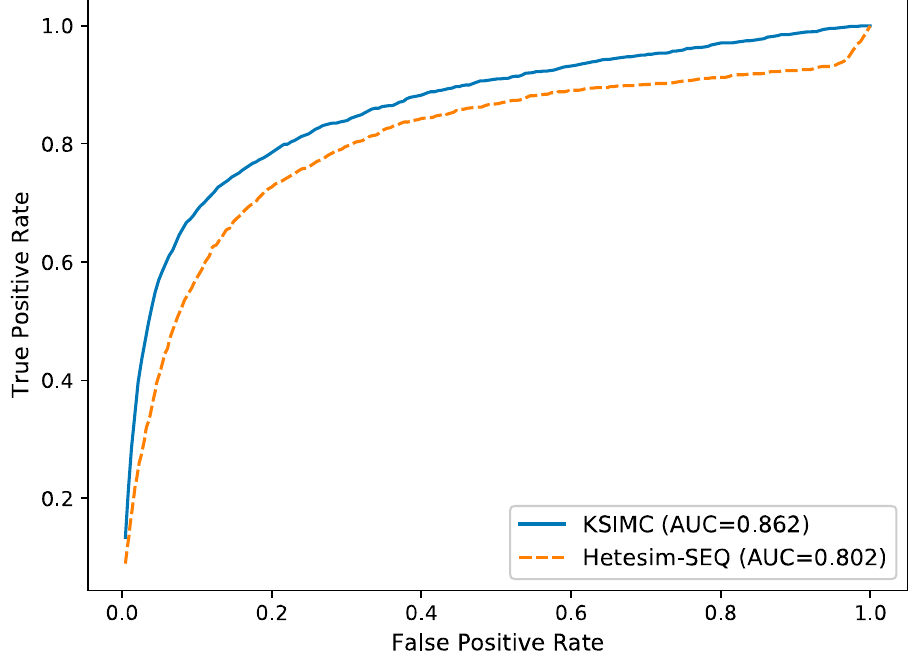
Figure 1. The ROC curves for predicting kinase–substrate interactions with different methods.